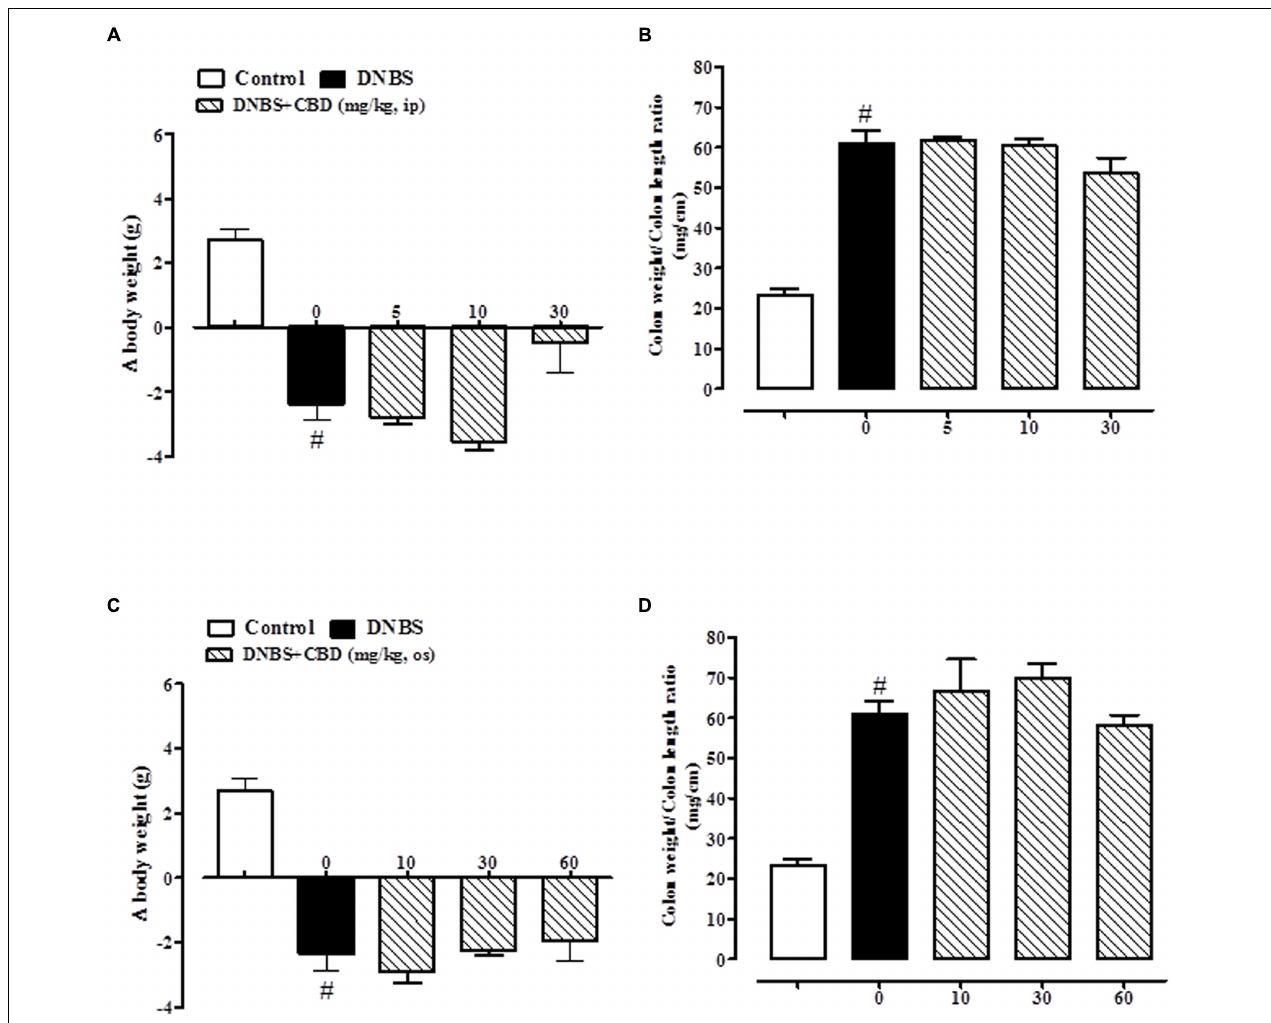
FIGURE 2 | Effect of pure CBD (5–30 mg/kg, intraperitoneally) on body weight (A) and colon weight/colon length ratio (B) and effect of pure CBD (10–60 mg/kg, by oral gavage) on body weight (C) and colon weight/colon length ratio (D) in DNBS induced colitis in mice (DNBS, 150 mg/kg, intracolonically). Pure CBD was given once a day for three consecutive days starting from 1 day after DNBS administration. Mice were euthanized 3 days after DNBS. Mice were weighted before DNBS (or vehicle) administration and immediately before the sacrifice. Bars are mean ± SEM of 8–12 mice for each experimental group. # p < 0.001 vs.